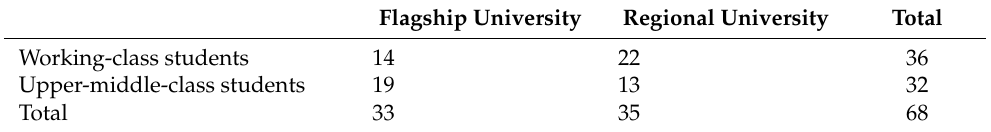
Table A2. Sample/comparison